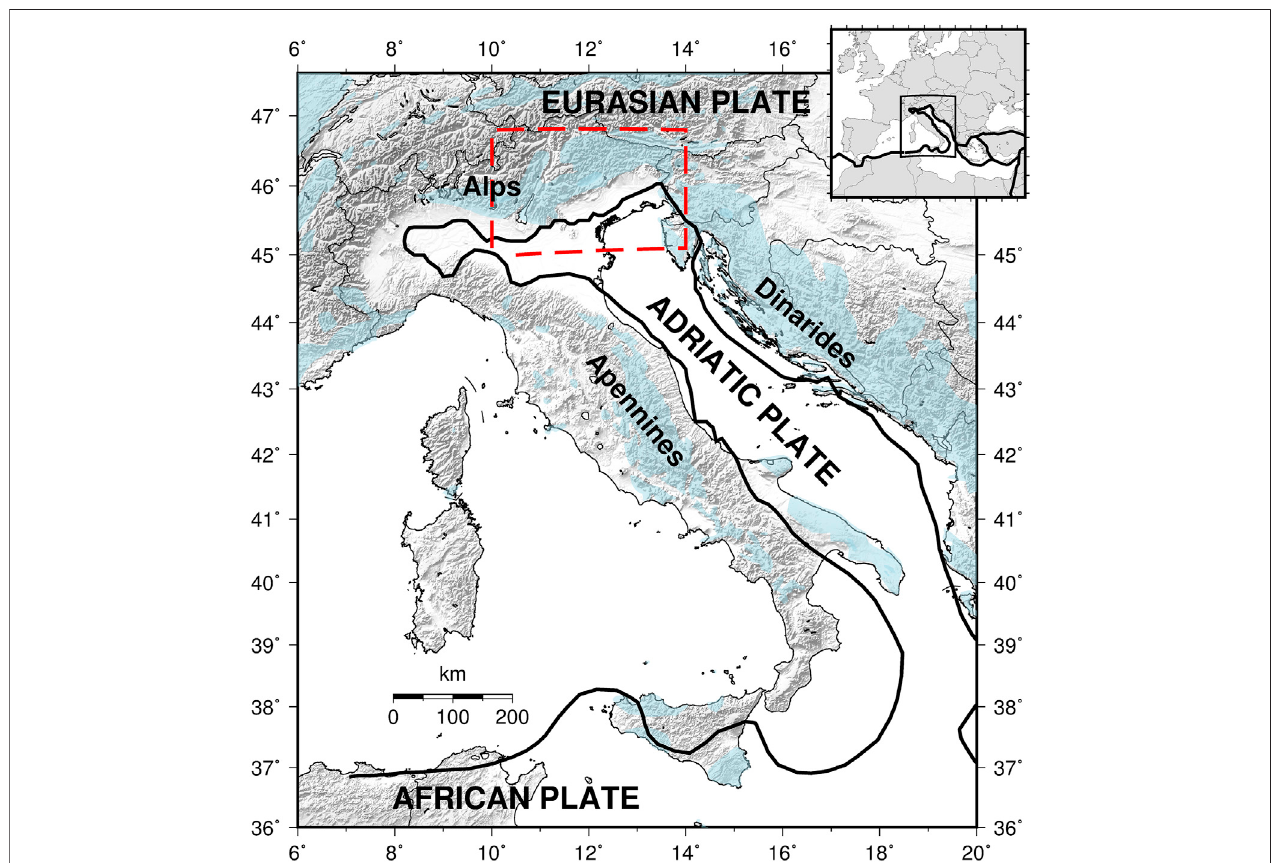
FIGURE 2 | Tectonic setting of Italy with the indication of the study area (dashed red rectangle). In light blue the carbonate rock outcrops (https://www.fos. auckland.ac.nz/our_research/karst/).